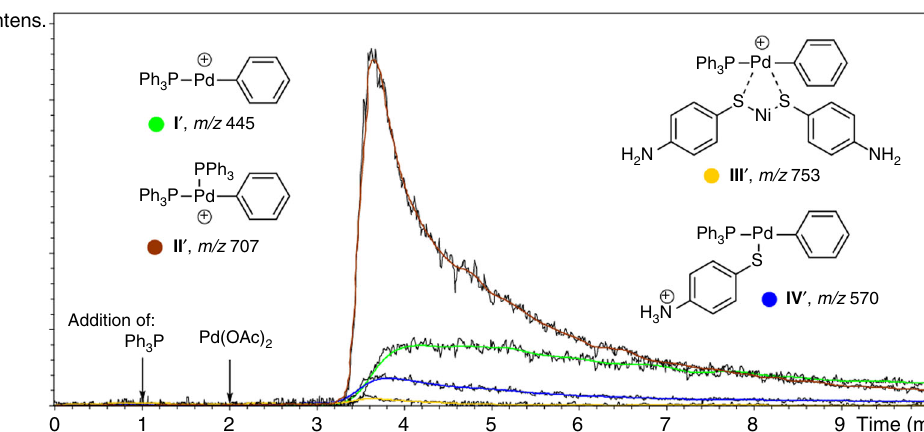
Fig. 7 ESI-MS study in positive ion mode. Intermediate ions detected during on-line monitoring of the reaction between iodobenzene ( 2a ) and nickel thiolate 1i . Black curves represent experimental raw data, colored curves correspond to Gauss smoothed representation (3 sec step, 5